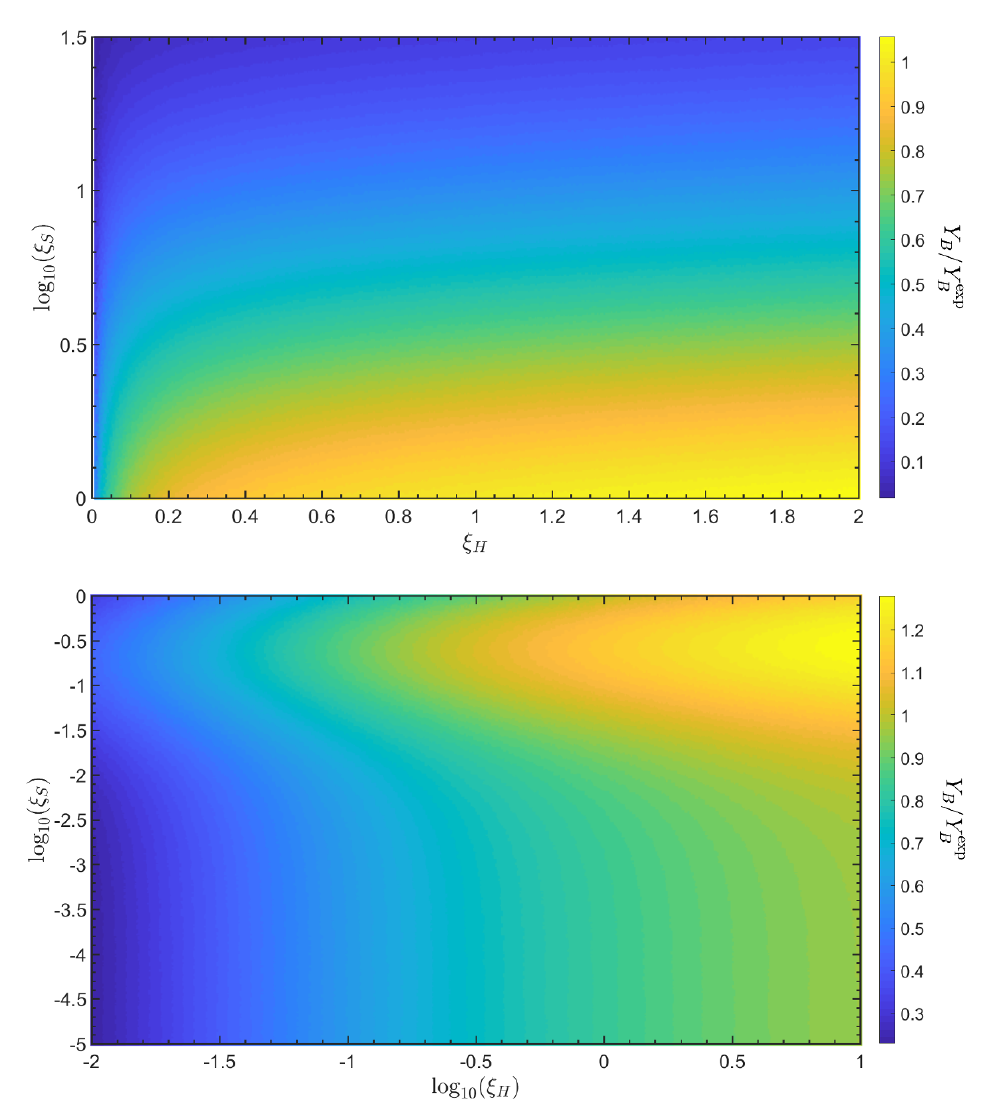
Figure 2 . Baryon asymmetry for a benchmark point with lowest value of (cid:31) 2 for a SFPT (singlet (cid:12)rst) phase transition with varying values of the three body rates. The horizontal axis varies the three body rates involving (s)tops and Higgs(inos). The vertical axis varies the three body rates involving singlets or singlinos.